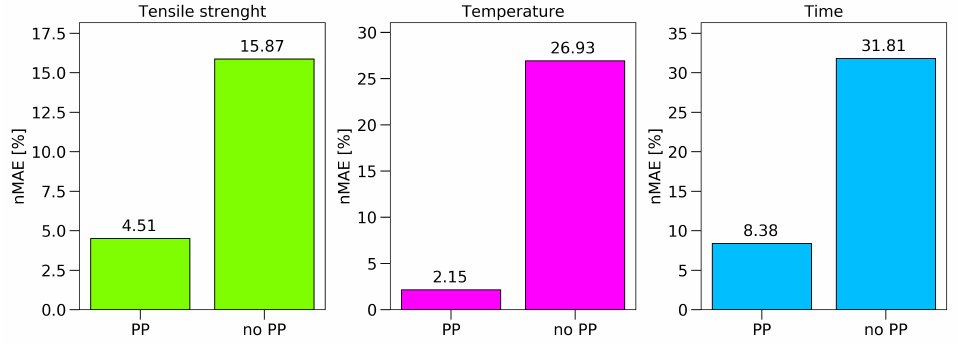
Figure 13. Prediction after optimized pre-processing versus prediction without pre-processing application for temperature, time, and tensile